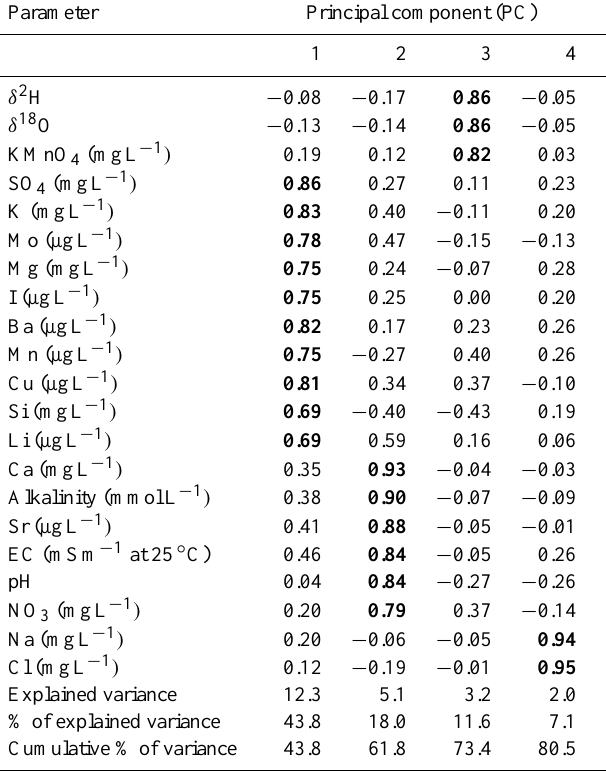
Table 4. Factor score from principal component loading contribut- ing to each case (observation wells and seasons, where 0412 and 0812 represent samples taken during April 2012 and August 2012, respectively). Positive factor scores are marked as